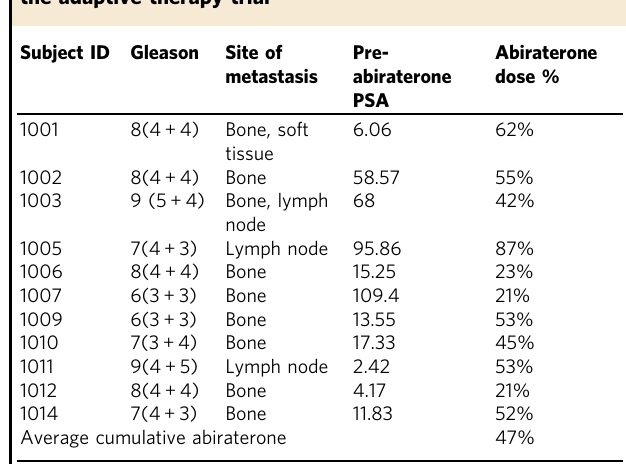
Table 2 Summary of the diseases status of the 11 patients